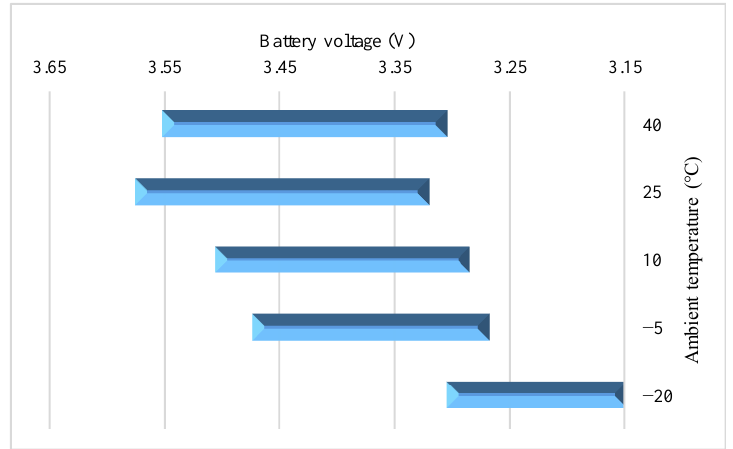
Figure 12. The voltage variation interval diagram of the voltage plateau period during 0.5C dis- charge.